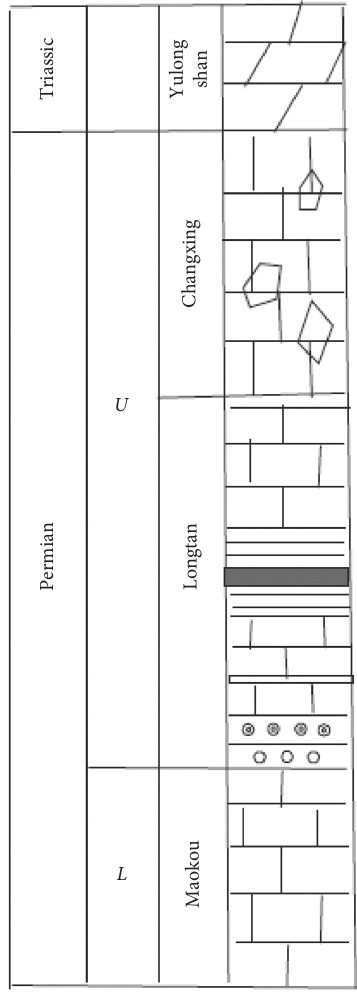
Figure 1: The representative stratigraphic column of the coalfields in south